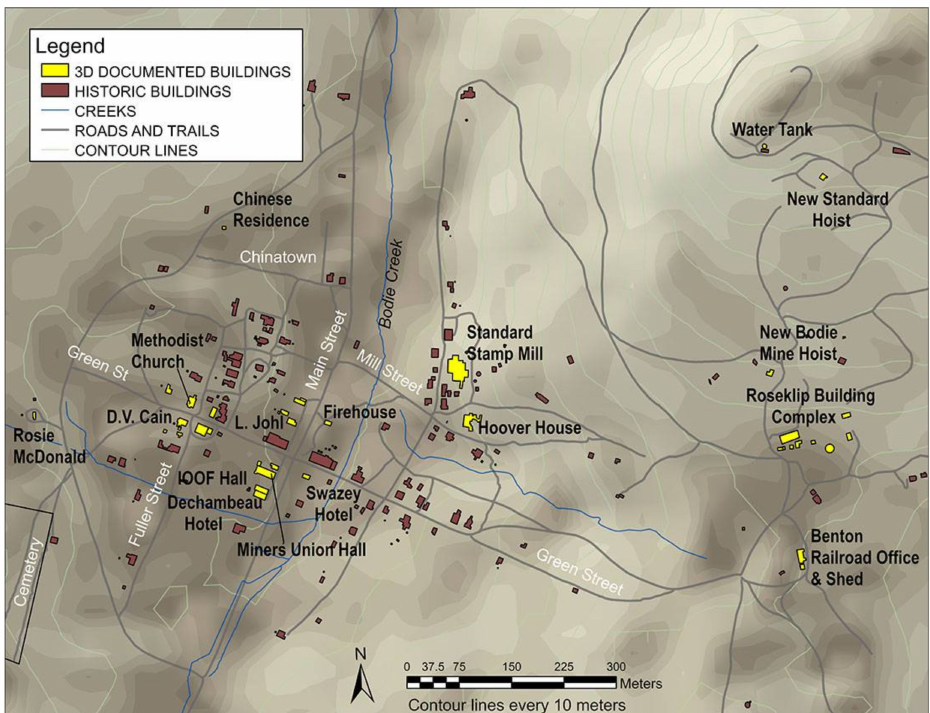
Figure 10. Map showing Bodie’s downtown, Chinatown, roads, and creeks. 3D documented buildings are seen in yellow. Generated from data made available by California State Parks and NASA JPL (2021). NASADEM Merged DEM Global 1 arc second V001. Distributed by OpenTopography. https://doi.org/10.5069/G93T9FD9 Accessed: 23 August 2021. Map by A.